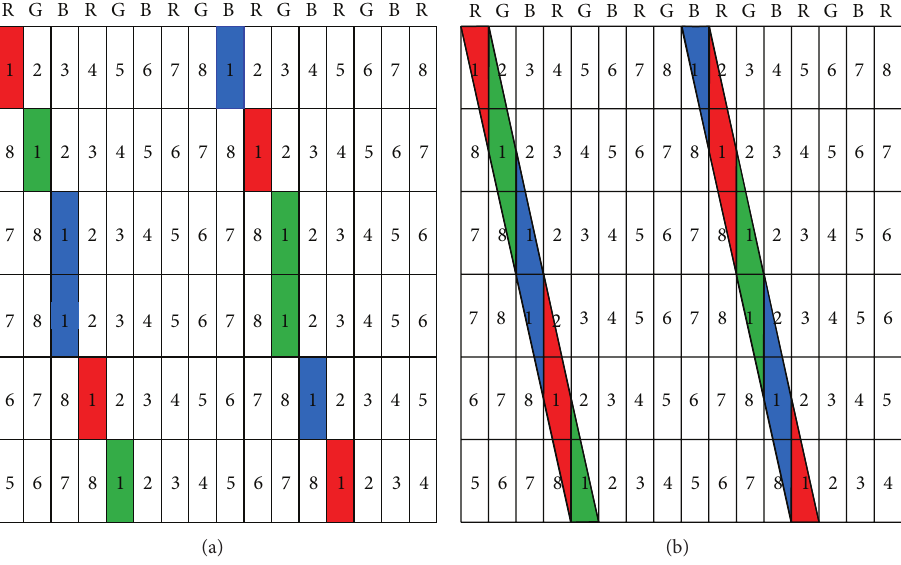
Figure 2: Distribution mode of 8 different view images’ subpixels on the synthetic image. (a) View image prepared for the first viewing position. (b) Visible image observed through the slits at the first viewing